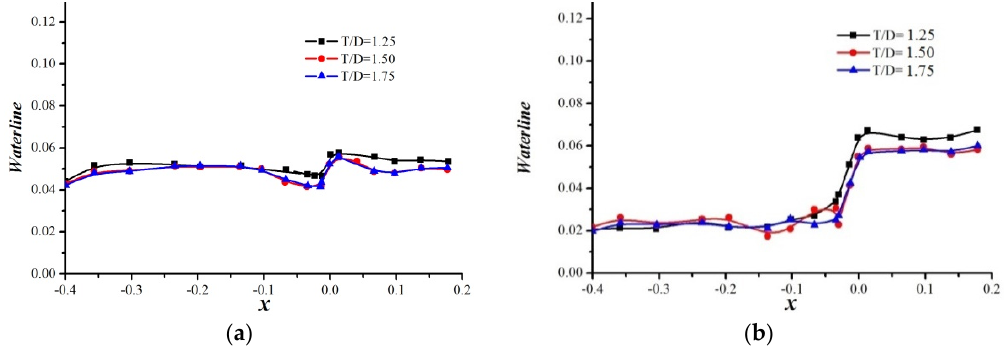
Figure 9. The water level along the central axis ( y = 0). ( a ) G/D = 8.0, ( b ) G/D = 1.0.